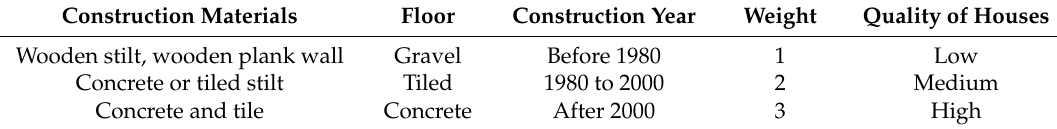
Table 3. Ranking of house quality by construction year and materials.